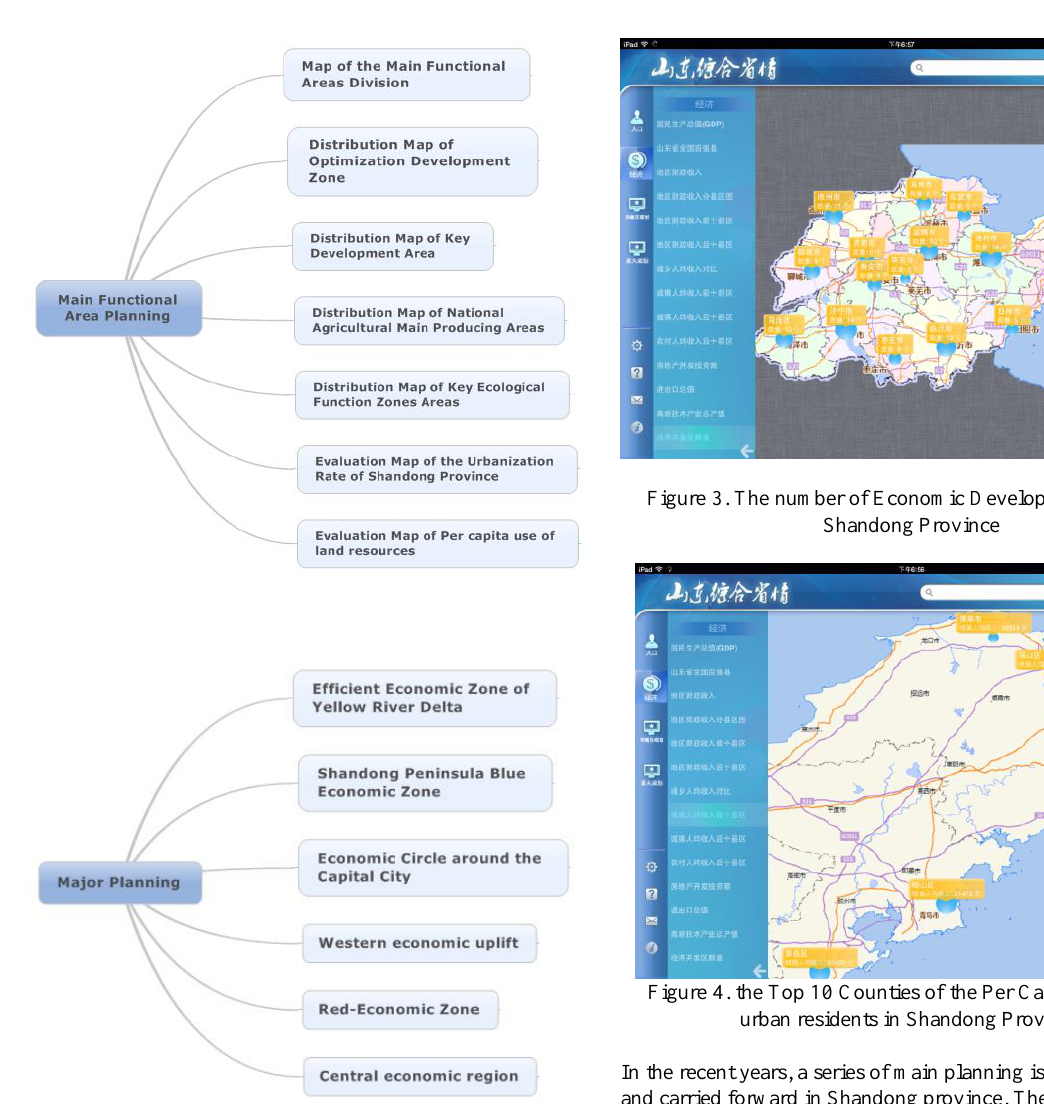
Figure 1. The four main types of statistical charts and maps in Shandong General Provincial Situation Visualization System